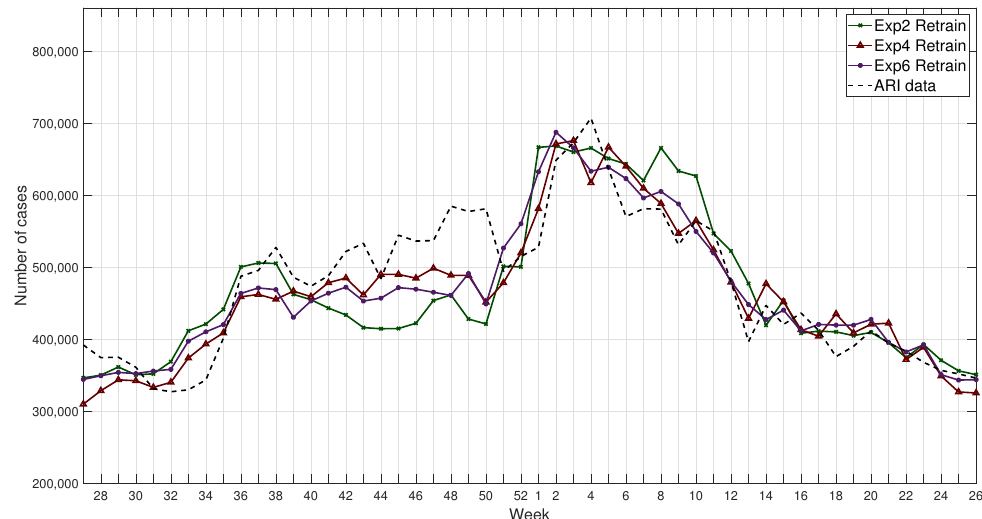
Figure 9. Example of results for retrained networks for the 2017–2018 winter season compared with ARI data.